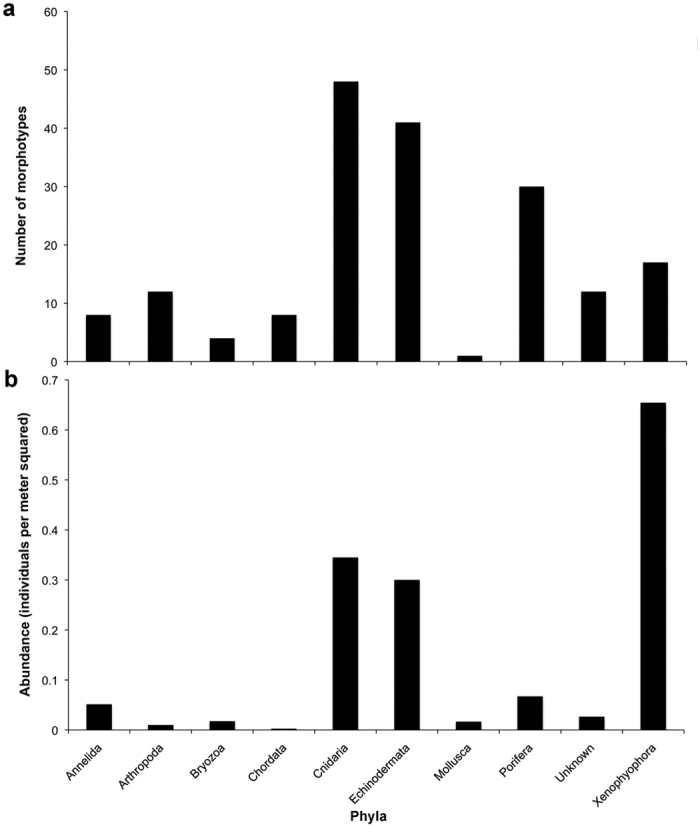
Megafaunal morphotype richness and individual abundance observed during AB01.(a) Megafaunal morphotype richness by phylum or other grouping in the case of xenophyophores. (b) Megafaunal abundance by phylum or other grouping in the case of xenophyophores. ‘Unknown’ refers to morphotypes that could not be assigned to a phylum.